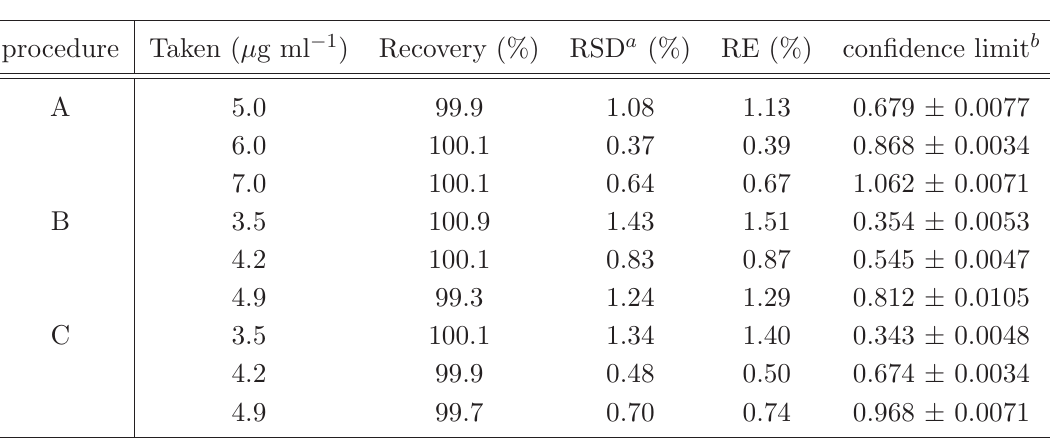
Table 2 Evaluation of accuracy and precision of the proposed